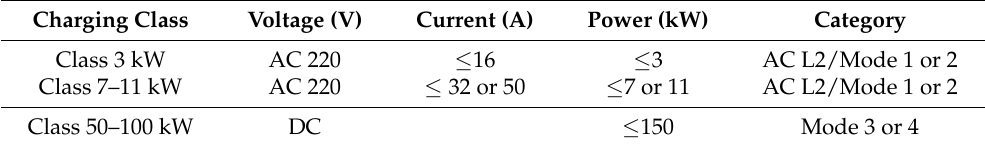
Table 3. EV charging classes (South